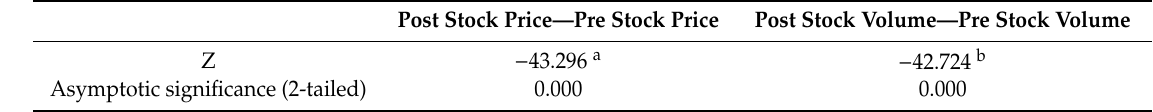
Table 2. Research results.